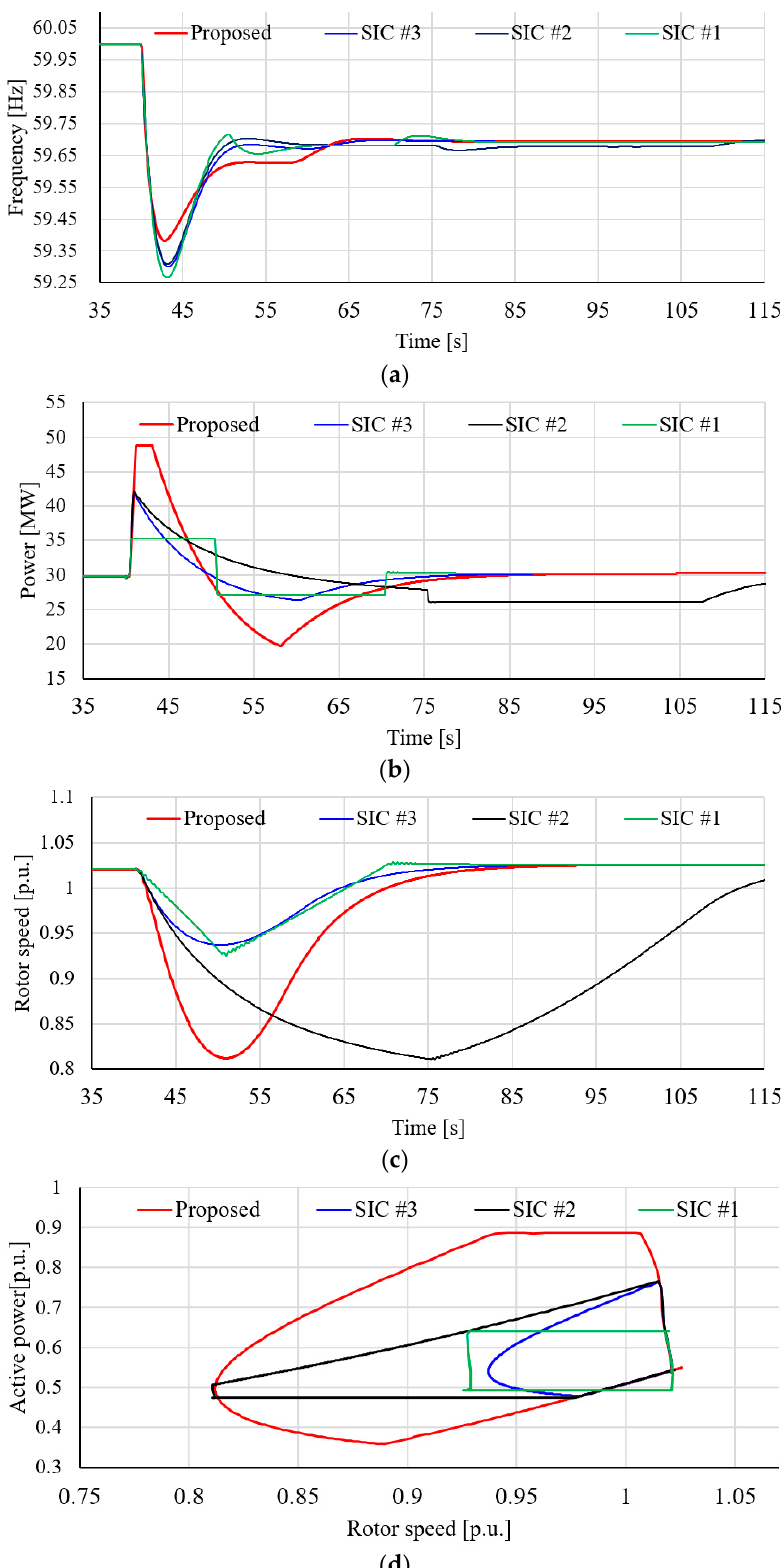
Figure 10. Results for Case 3. ( a ) System frequency; ( b ) Output power of the wind farm; ( c ) Rotor speed; ( d ) Output power in the rotor speed domain.